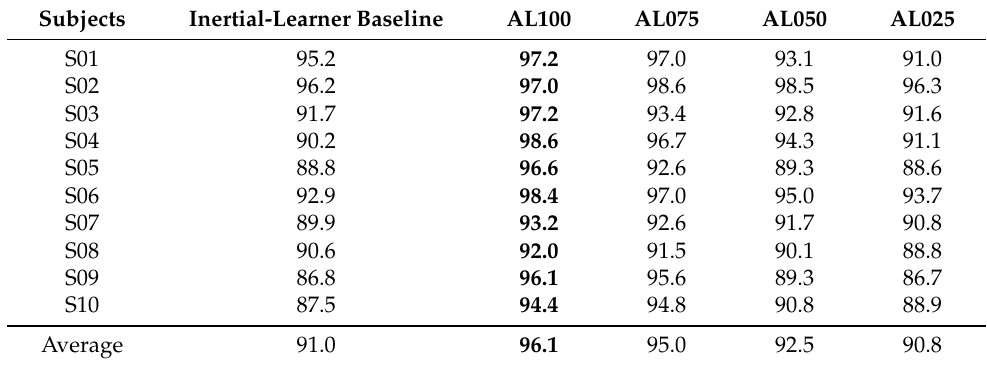
Table 9. Relationship to compare the performance of the Inertial average classification (expressed in percentage) model in contrast to the baseline and the four different alternatives over the AL approach. Subjects Inertial-Learner